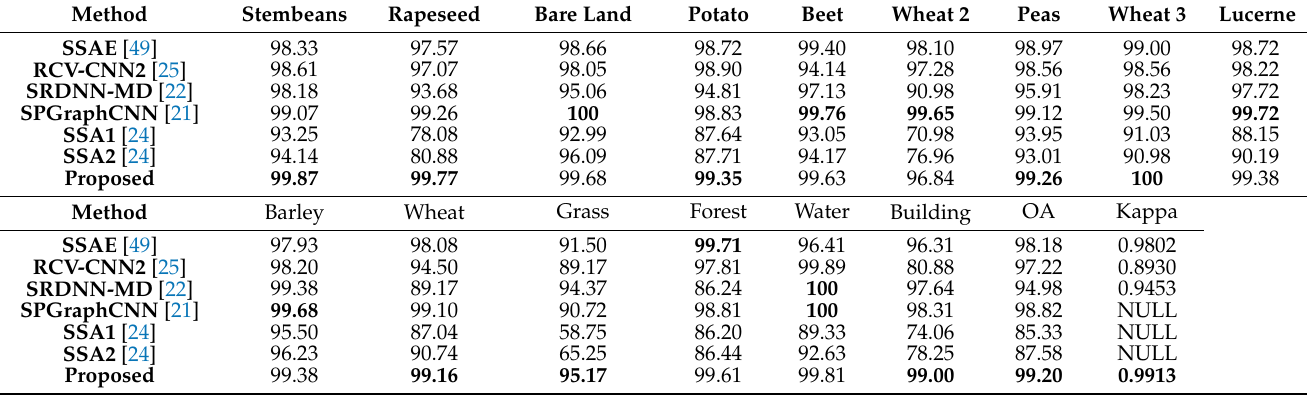
Table 3. Accuracy and Kappa coefficients of dataset 1 for seven semi-supervised methods under the condition of 1% sample